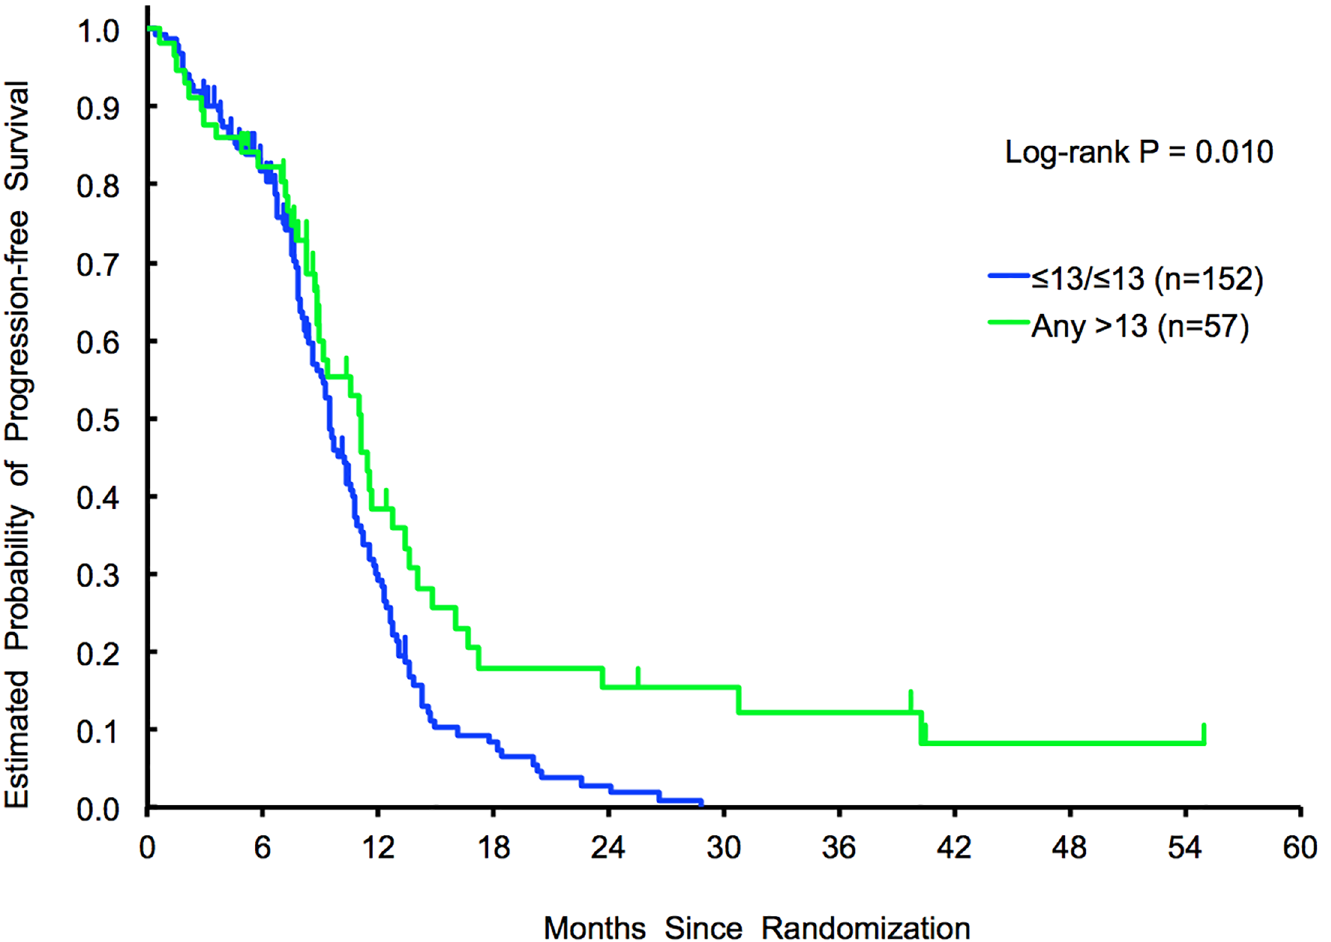
Fig 1. Exploratory cohort 1 (tribe—A). PFS results in any > 13 repeats vs (cid:20) 13/ (cid:20) 13repeats .